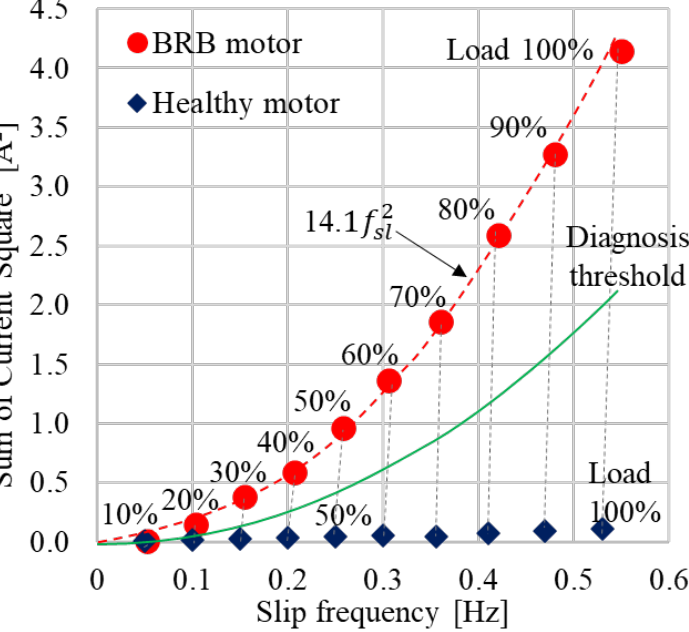
Figure 7. Experimental results of sum of Fourier series coefficients square versus slip frequency with BRB fault and healthy motor.